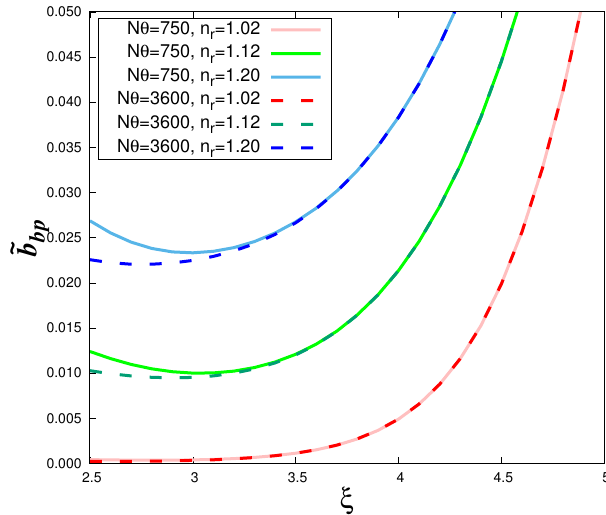
Figure 4. Results of Lorentz-Mie calculations (DS1) of the particulate backscattering ratio (cid:102) b θ a a function of the hyperbolic slope, ξ , and different values of n r and N θ . The imaginary part of the refractive index = 0.005 as in Twardowski et al. [5]. This figure can be compared to Figure 1 in Twardowski et al.